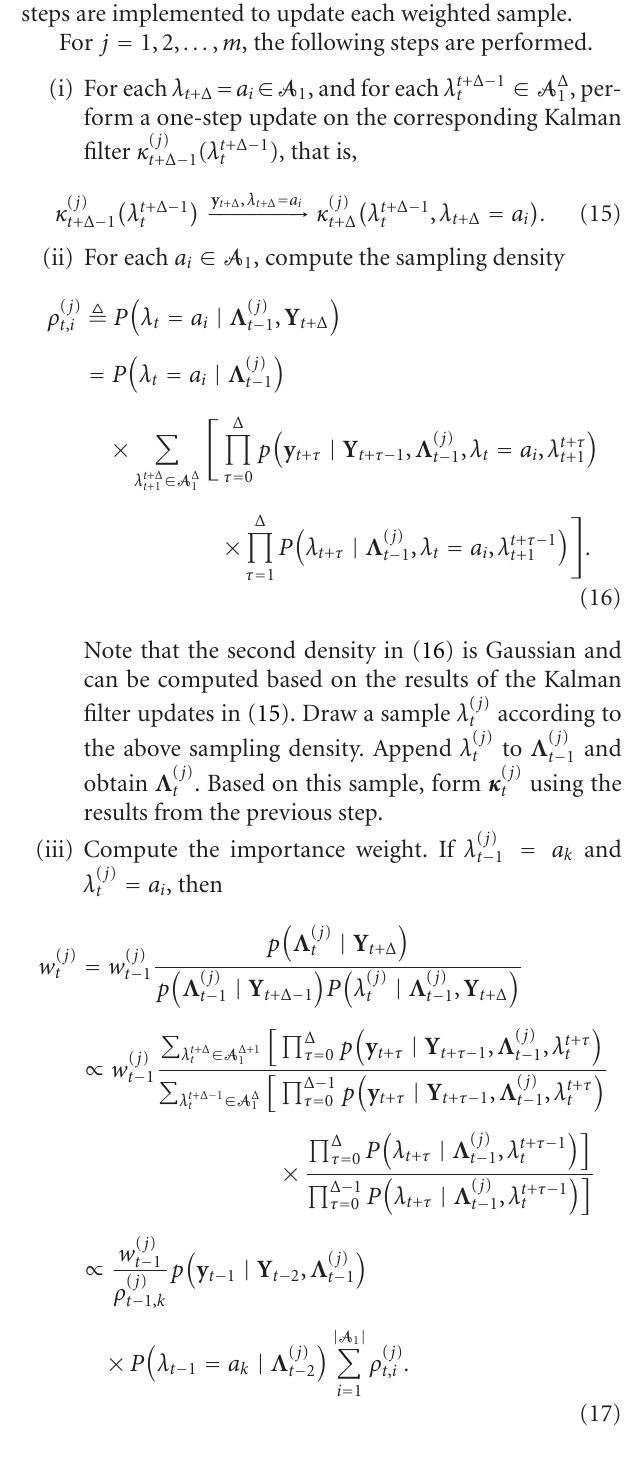
The delayed-sample MKF algorithm recursively